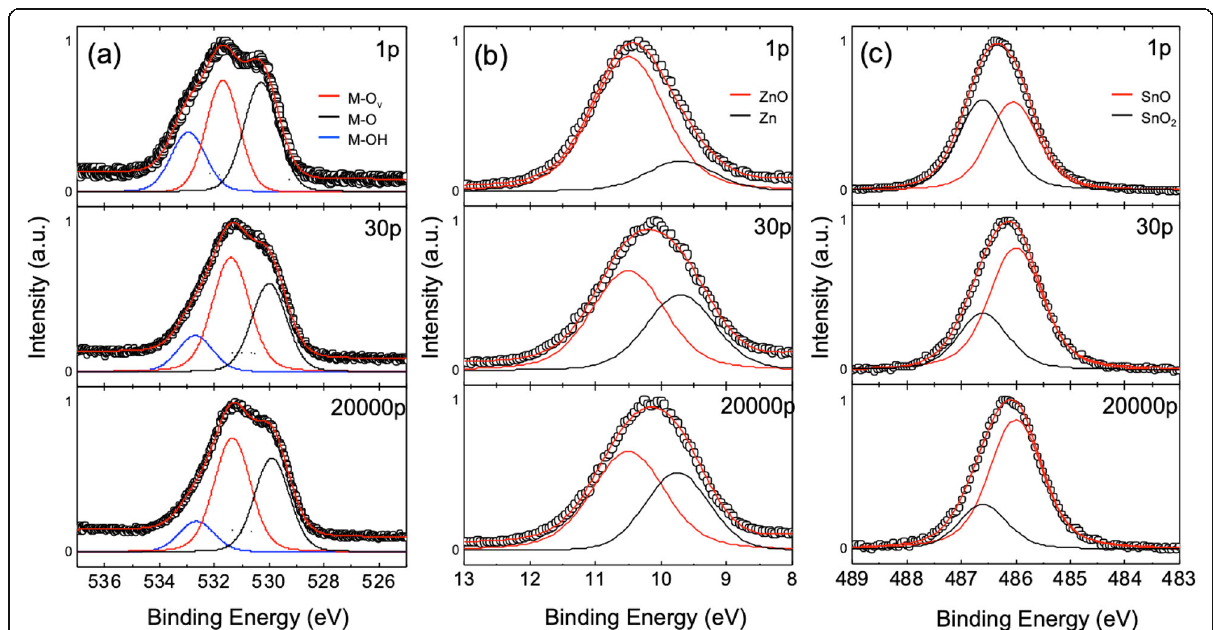
Fig. 3 The changes of XPS core-level spectra of a O 1 s , b Zn 3d , and c Sn 3d in ZTO thin films over the number of laser pulses (photoelectron emission angle of